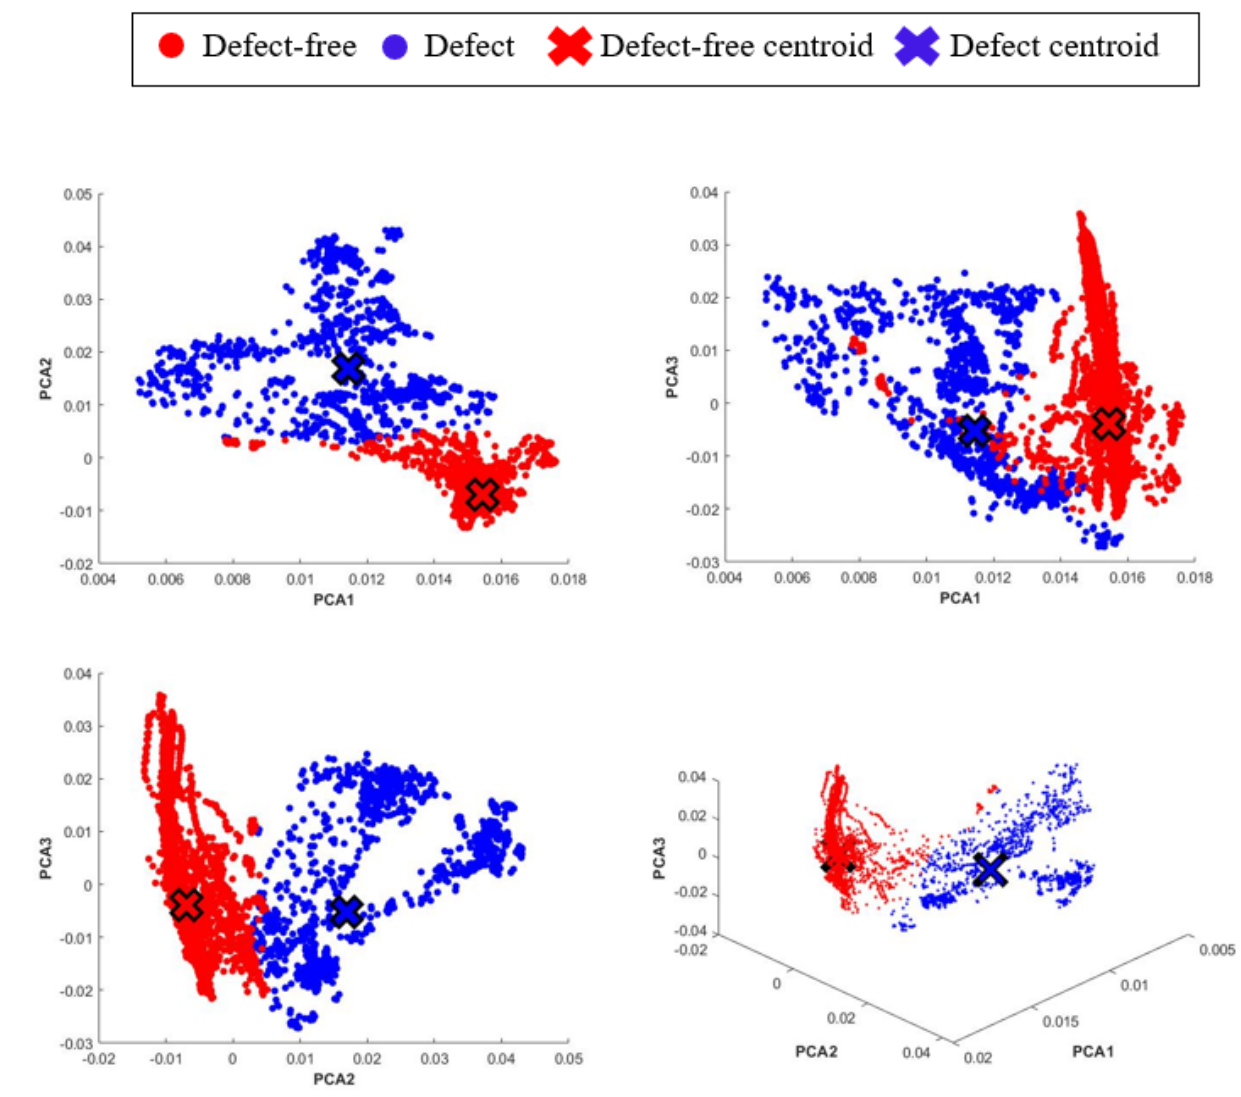
Figure 12. Scattering graphs depict the datasets from the three PCA components with regard to the groups of delamination and non-delamination for each investigated position.